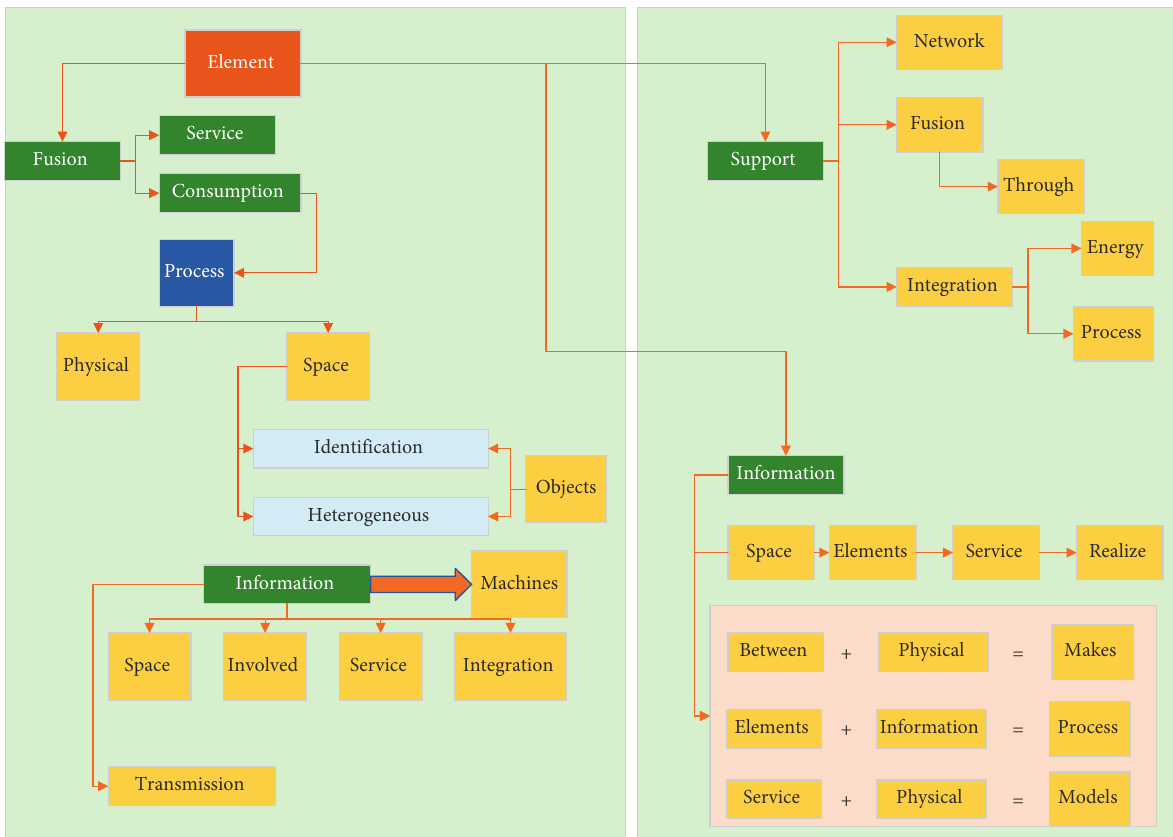
Figure 3: Schematic diagram of the graph theory